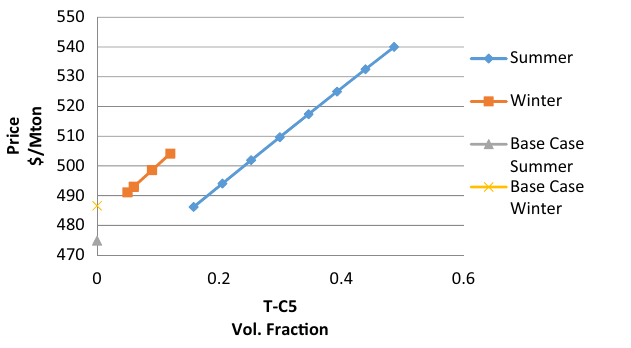
Fig. 27 Effect of adding a mixture of 2,2DMP and i-C5 on LPG price